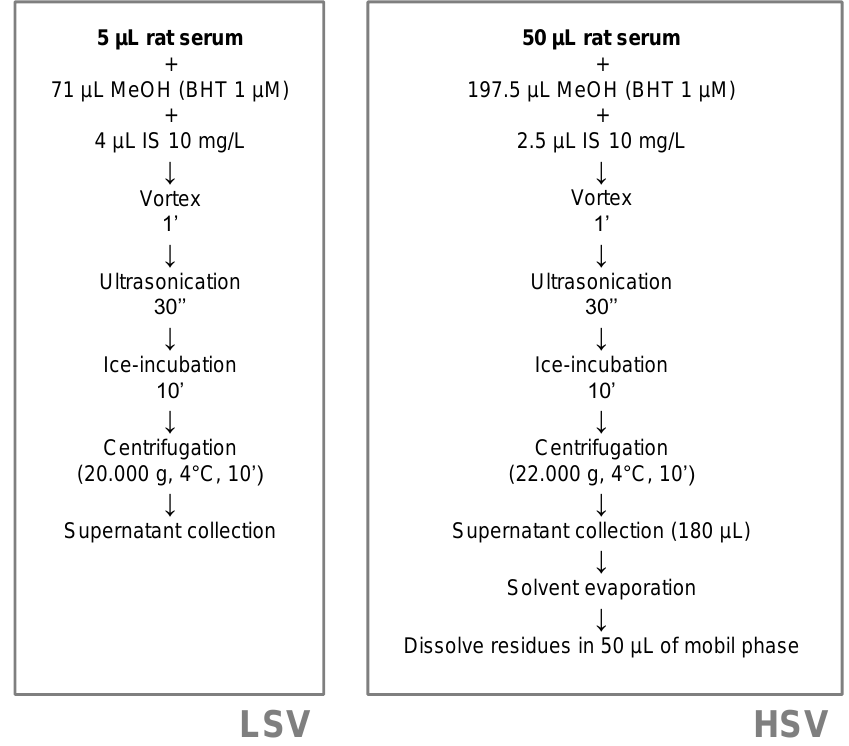
Figure 4. Extraction procedures for the exhaustive metabolomics analysis of Lyso-PLs.